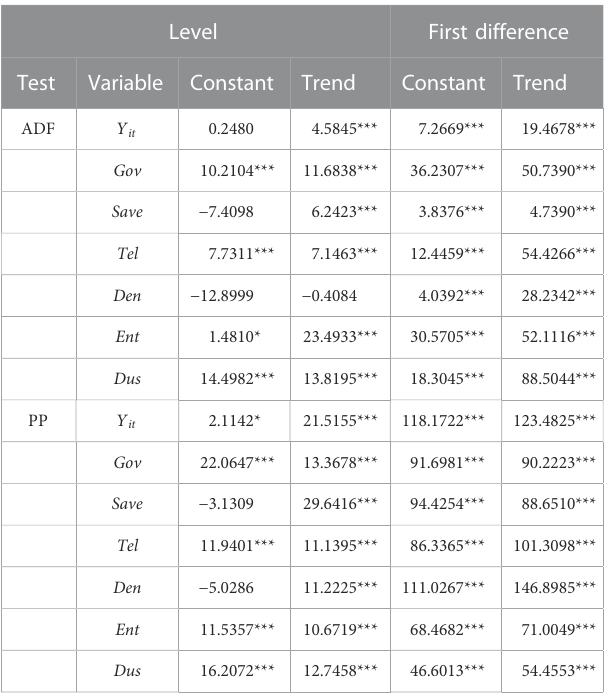
TABLE 5 Data smoothness test. TABLE 6 PSM estimation